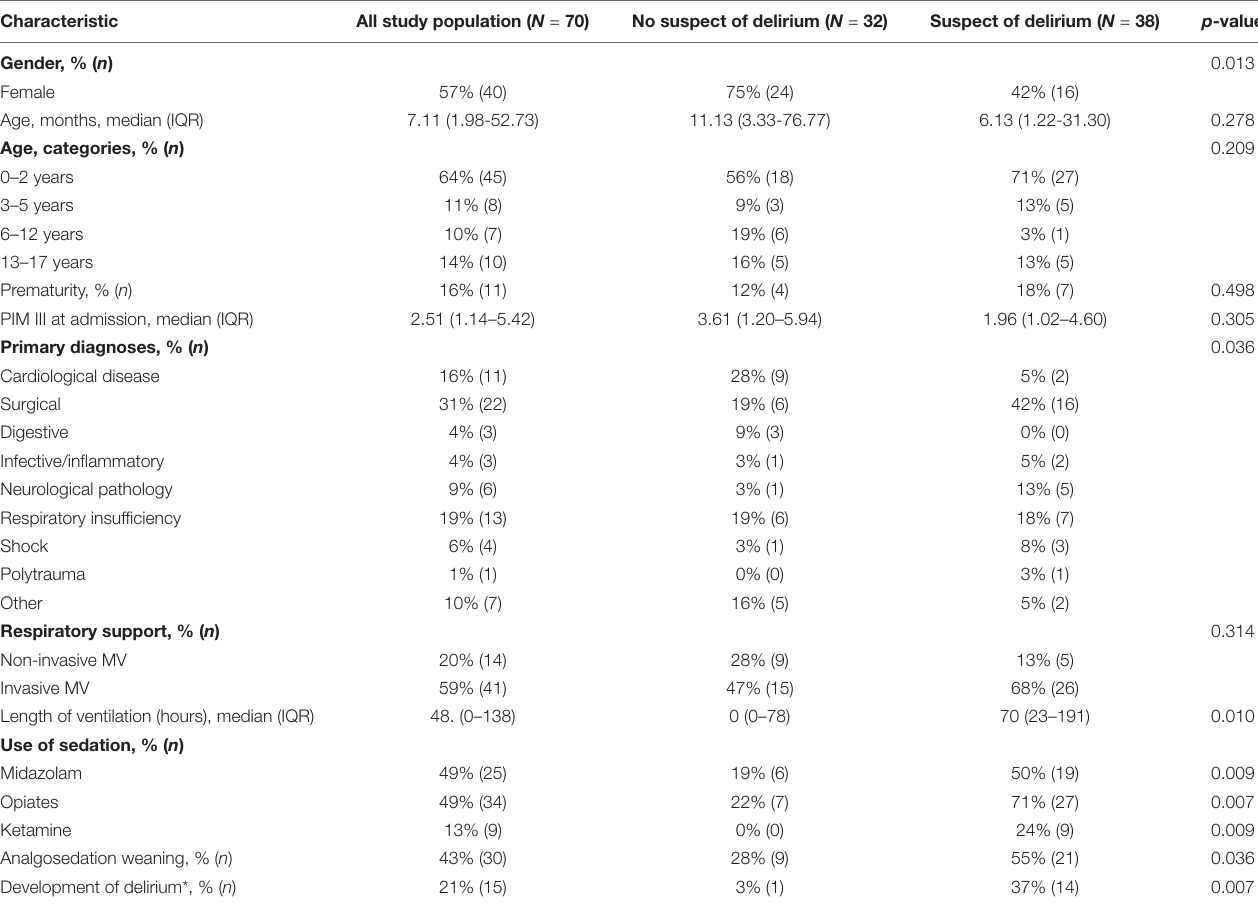
TABLE 1 | Characteristics and diagnosis of study subjects based on suspect of delirium (CAPD ≥